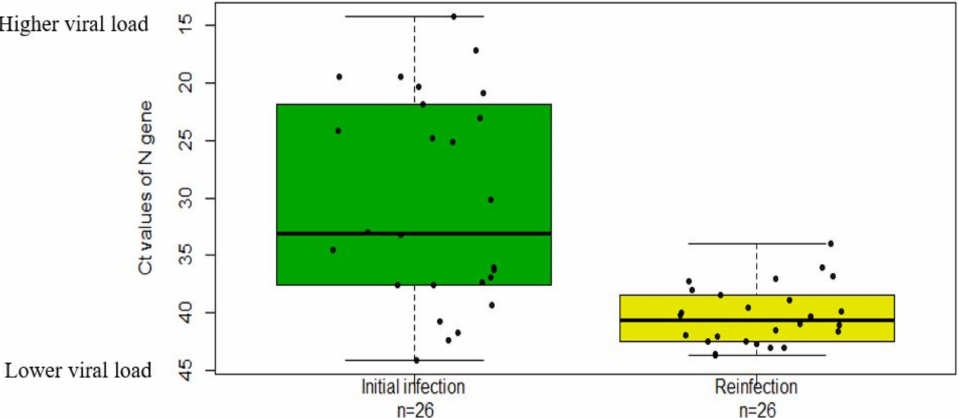
Figure 4. Comparison of mRT-PCR Ct values between the initial infection test and reinfection test. Ct values were generated from the N gene amplicon of the Xpert Xpress SARS-CoV-2 assay. For five subjects without N gene amplicon detection in either the initial or reinfection test, Ct values from the E gene amplicon of both the initial infection and the reinfection were used for analysis. Median values are represented by bolded horizontal lines, minimum and maximum values are represented by non-bolded horizontal lines, and boxes represent the 25–75th